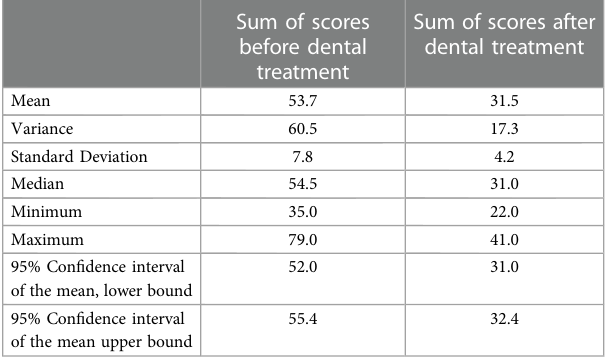
TABLE 6 Mean values of child oral health impact pro fi le-short form 19 (COHIP-SF-19) scores before and after dental treatment. Before After treatment treatment